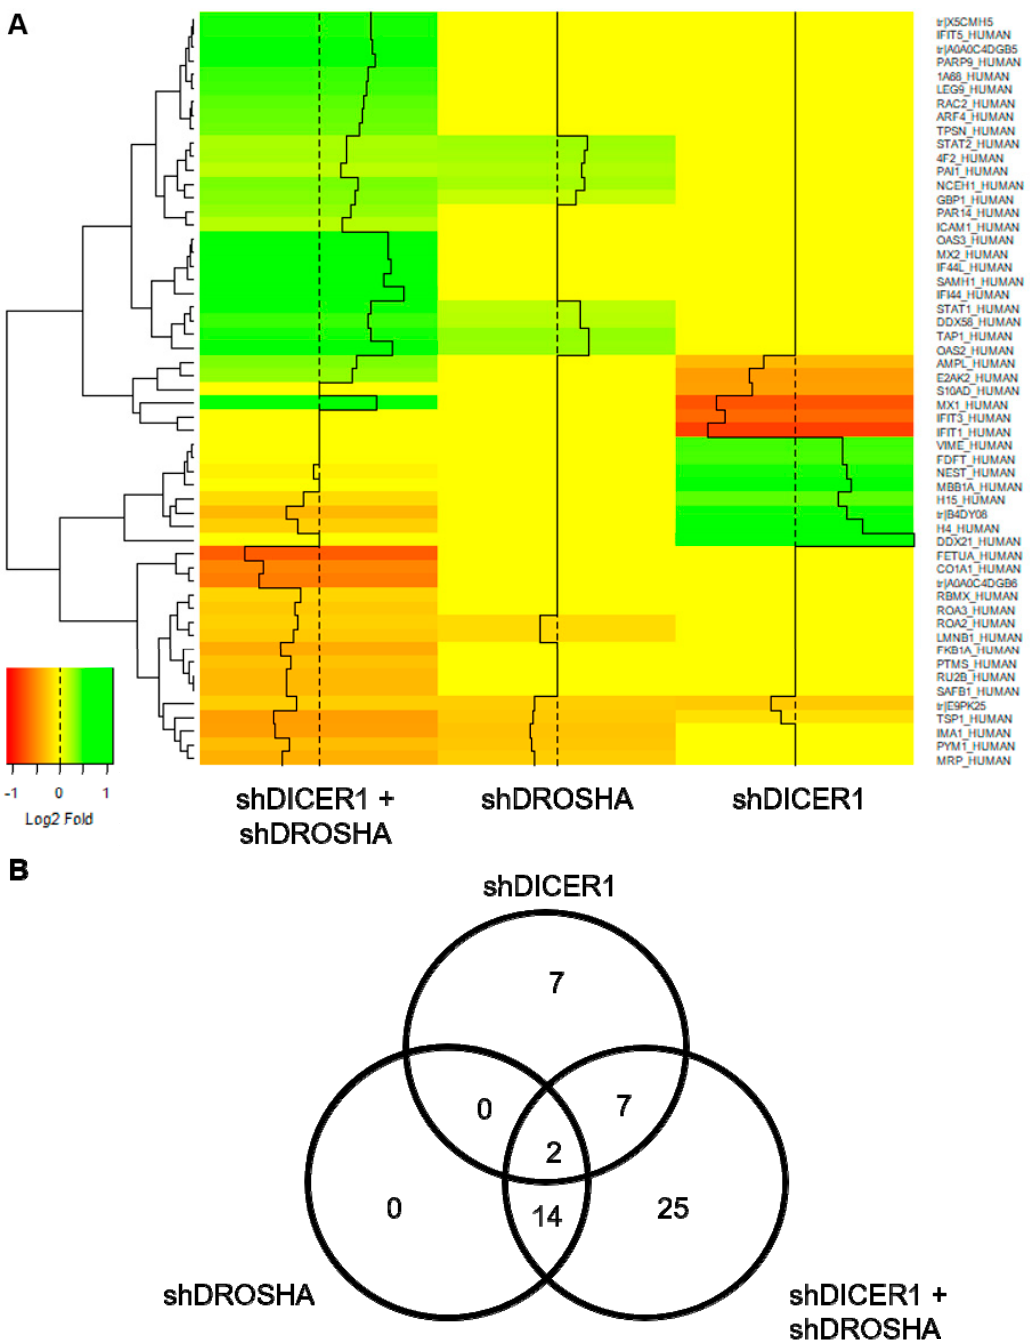
Figure 4. Global proteome analyses of HUVEC engineered to express specific shRNA directed against DICER1, DROSHA or DICER1 and DROSHA or non-targeting shRNA control. ( A ) Heat map visualisation of differentially expressed genes (DEGs) identified in global proteome analyses of HUVEC, in which either DICER1, DROSHA or DICER1 and DROSHA knockdown was performed by stable expression of specific shRNA and compared to HUVEC stably expressing non-targeting shRNA control ( n = 3 biological replicates derived from independent lentiviral transductions for each experimental condition). The heatmap color range from green to orange represents the log2 fold expression value of control HUVEC in which green denotes genes with high expression levels and orange denotes genes with low expression levels. In these unbiased analyses, for instance, a reduced expression of anti-angiogenic thrombospondin-1 (TSP-1) was observed in DICER1, DROSHA and in particular in DICER1 and DROSHA knockdown HUVEC. ( B ) The number and overlap of DEGs in DICER1, DROSHA and DICER1 and DROSHA knockdown HUVEC is depicted by Venn